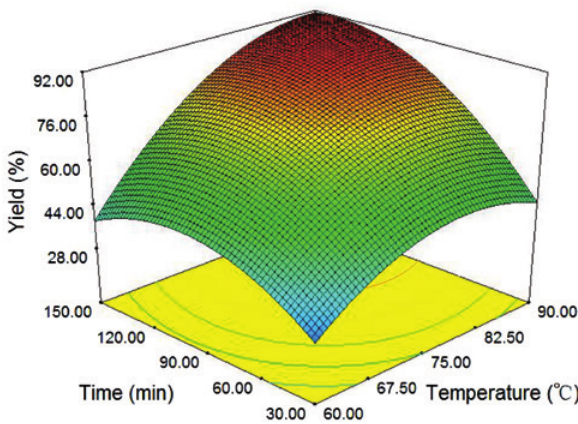
Figure 4: Three-dimensional response surface and contour plot of leaching time vs. temperature on CeO